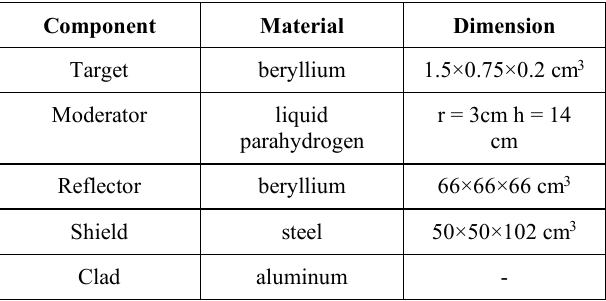
Table 1 . CNS structure